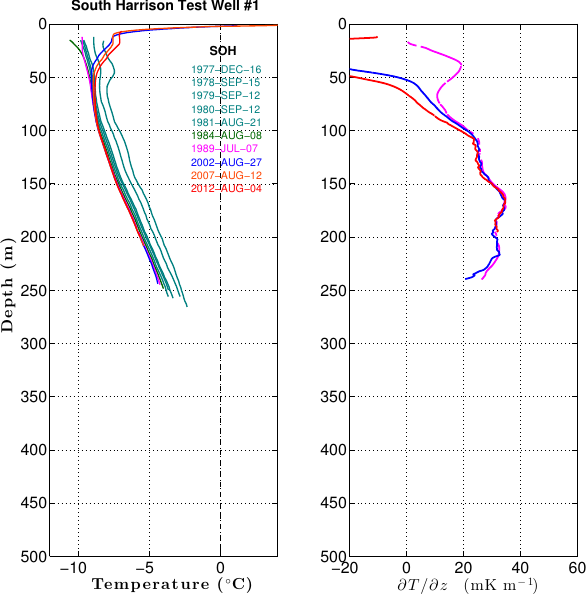
Figure 25. Temperature profiles in the South Harrison Test Well No. 1, color-coded by acquisition date (left). Temperature gradients calculated from the 1989, 2002, and 2012 logs are shown in the right panel. The accessible portion of this well does not reach the base of permafrost.